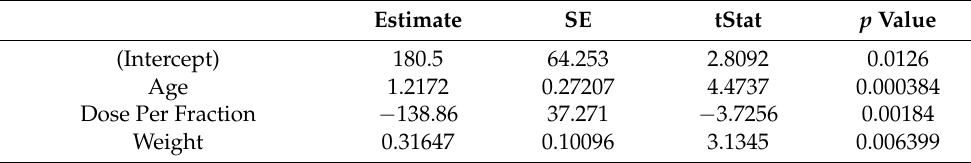
Table 4. Estimated coefficients used in AI coding.